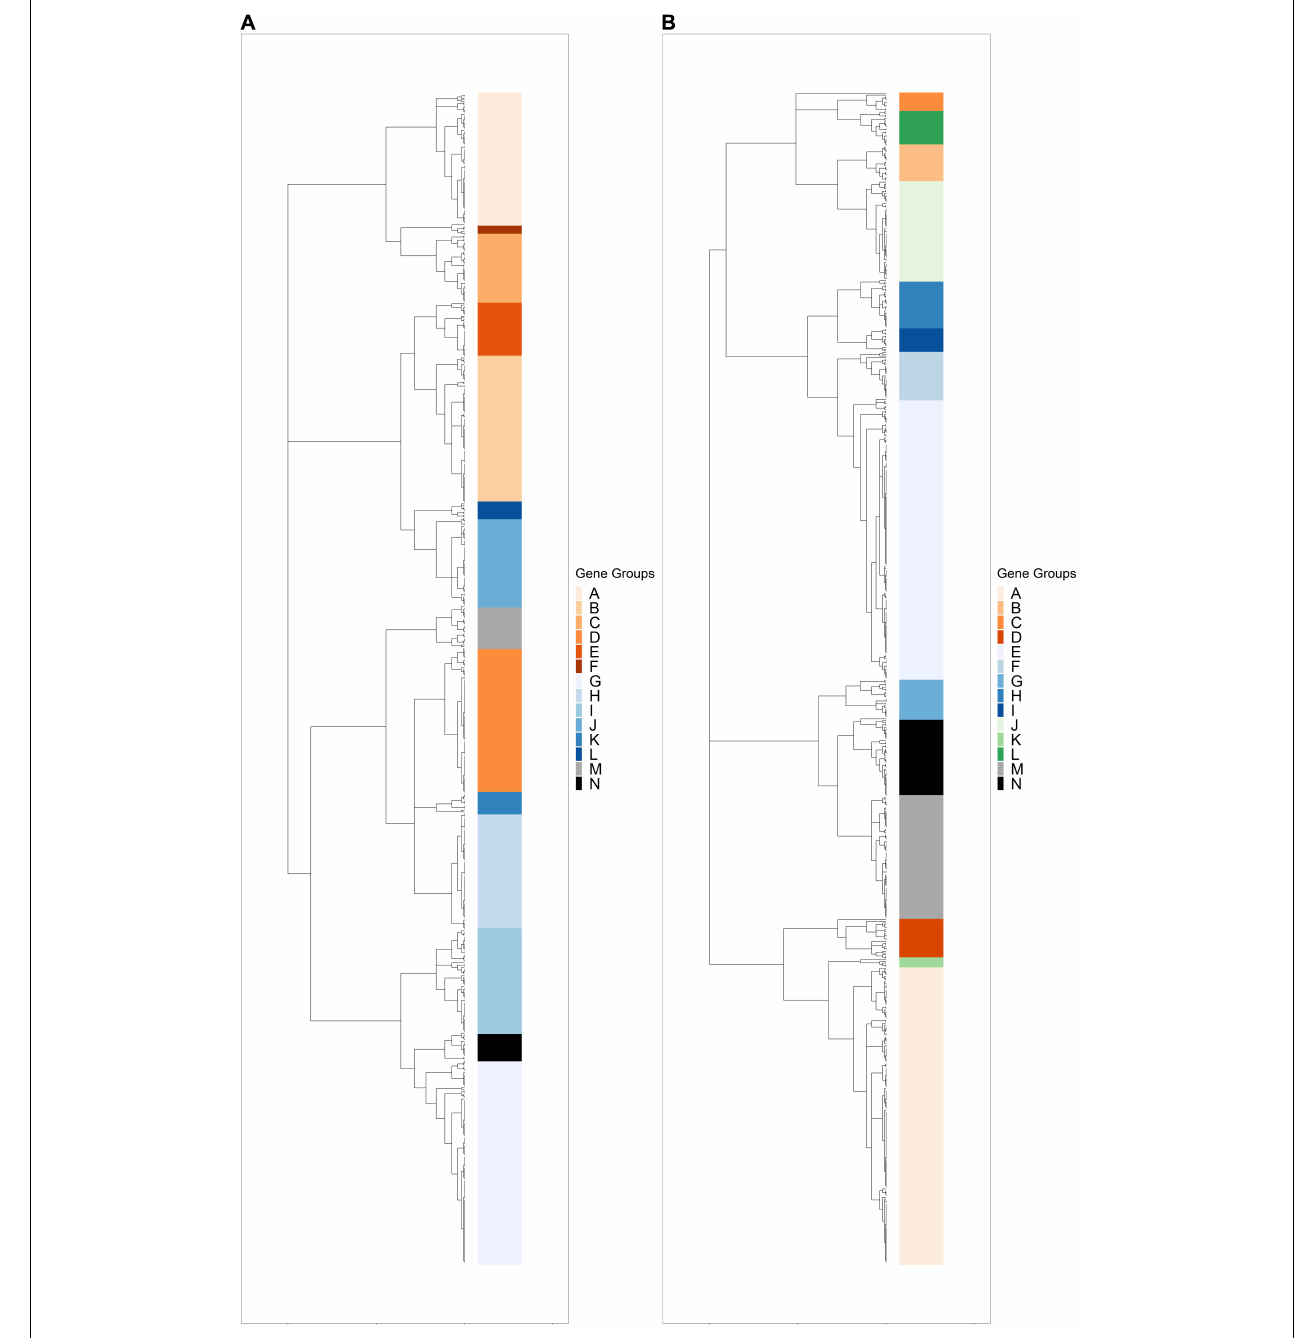
FIGURE 2 | Hierarchical clustering of rlog scaled count data through the light-dark cycle. Differentially expressed genes were clustered based on expression patterns through time, and any cluster with fewer than two genes was excluded. (A) Dendrogram of hierarchically clustered differentially expressed genes in R. lacicola . Putative light-responsive genes whose transcript abundance increases during the first hour in the light and decreases between one hour and six hours in the dark are colored in orange shades. Putative light-responsive genes whose transcript abundance generally decreases during the first hour in the light and increases between one hour and six hours in the dark are colored in blue shades. The groups colored black and gray appear to respond to darkness. (B) Dendrogram of hierarchically clustered differentially expressed genes in A. photophilum strain MWH-Mo1. Colors indicate gene groups with similar expression profiles. Orange shades indicate genes whose expression increases within one hour in the light and decreases within one hour in the dark. Blue shades indicate genes whose expression decreases within one hour in the light and increases within one hour in the dark. Green indicates genes whose expression increases within one hour in the light and decreases within 15 min in the dark. Black and gray indicates genes whose expression decreases within one hour in the light and increases within 15 min in the dark.